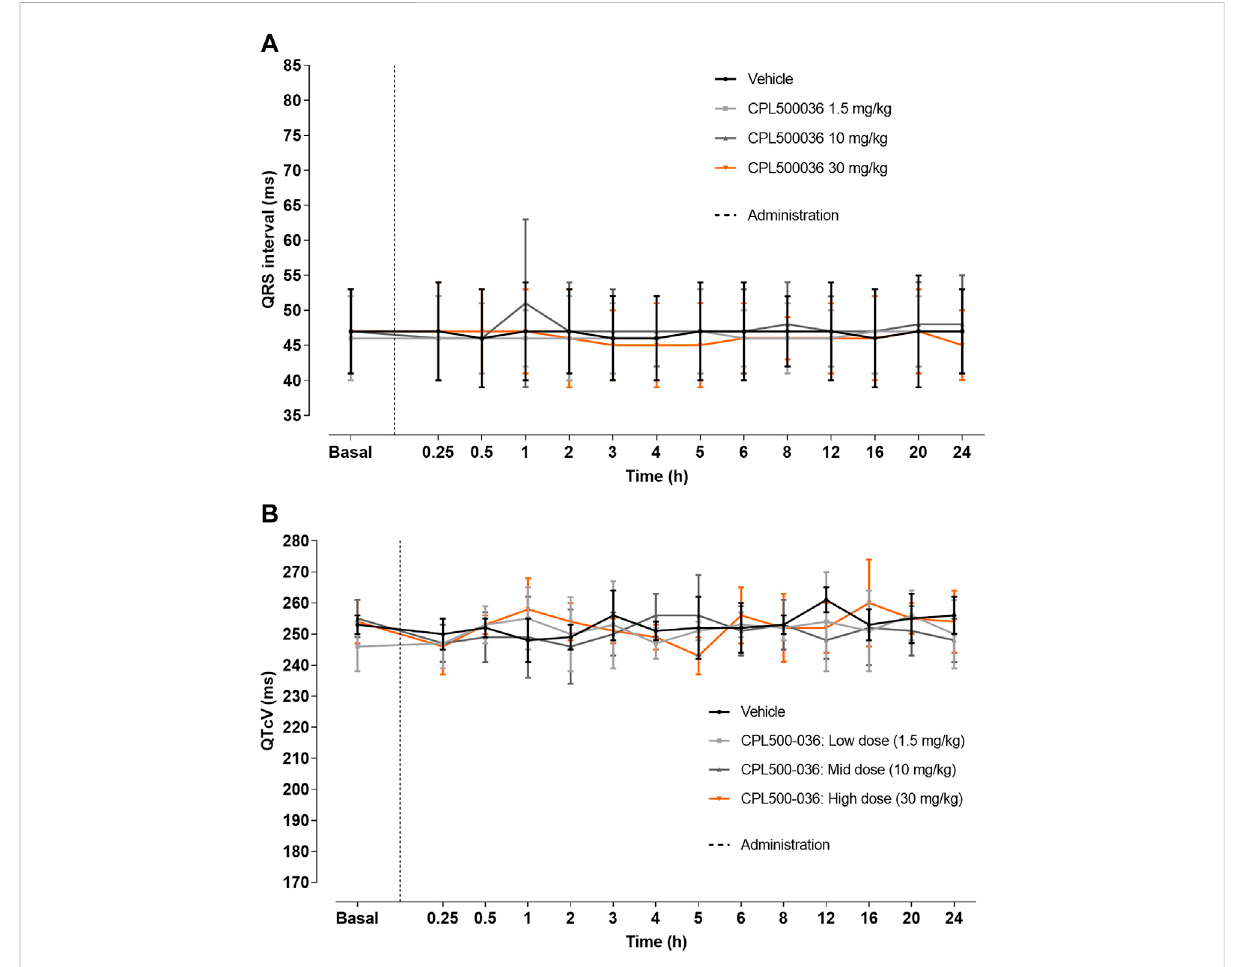
FIGURE 7 CPL500036 does not elicit changes in electrocardiography parameters. A single oral administration to Beagle dogs (1.5 mg/kg, 10 mg/kg or 30 mg/kg) did not induce alterations in QRS (A) or QTcV (B) intervals. Results are the mean ± SD; n =